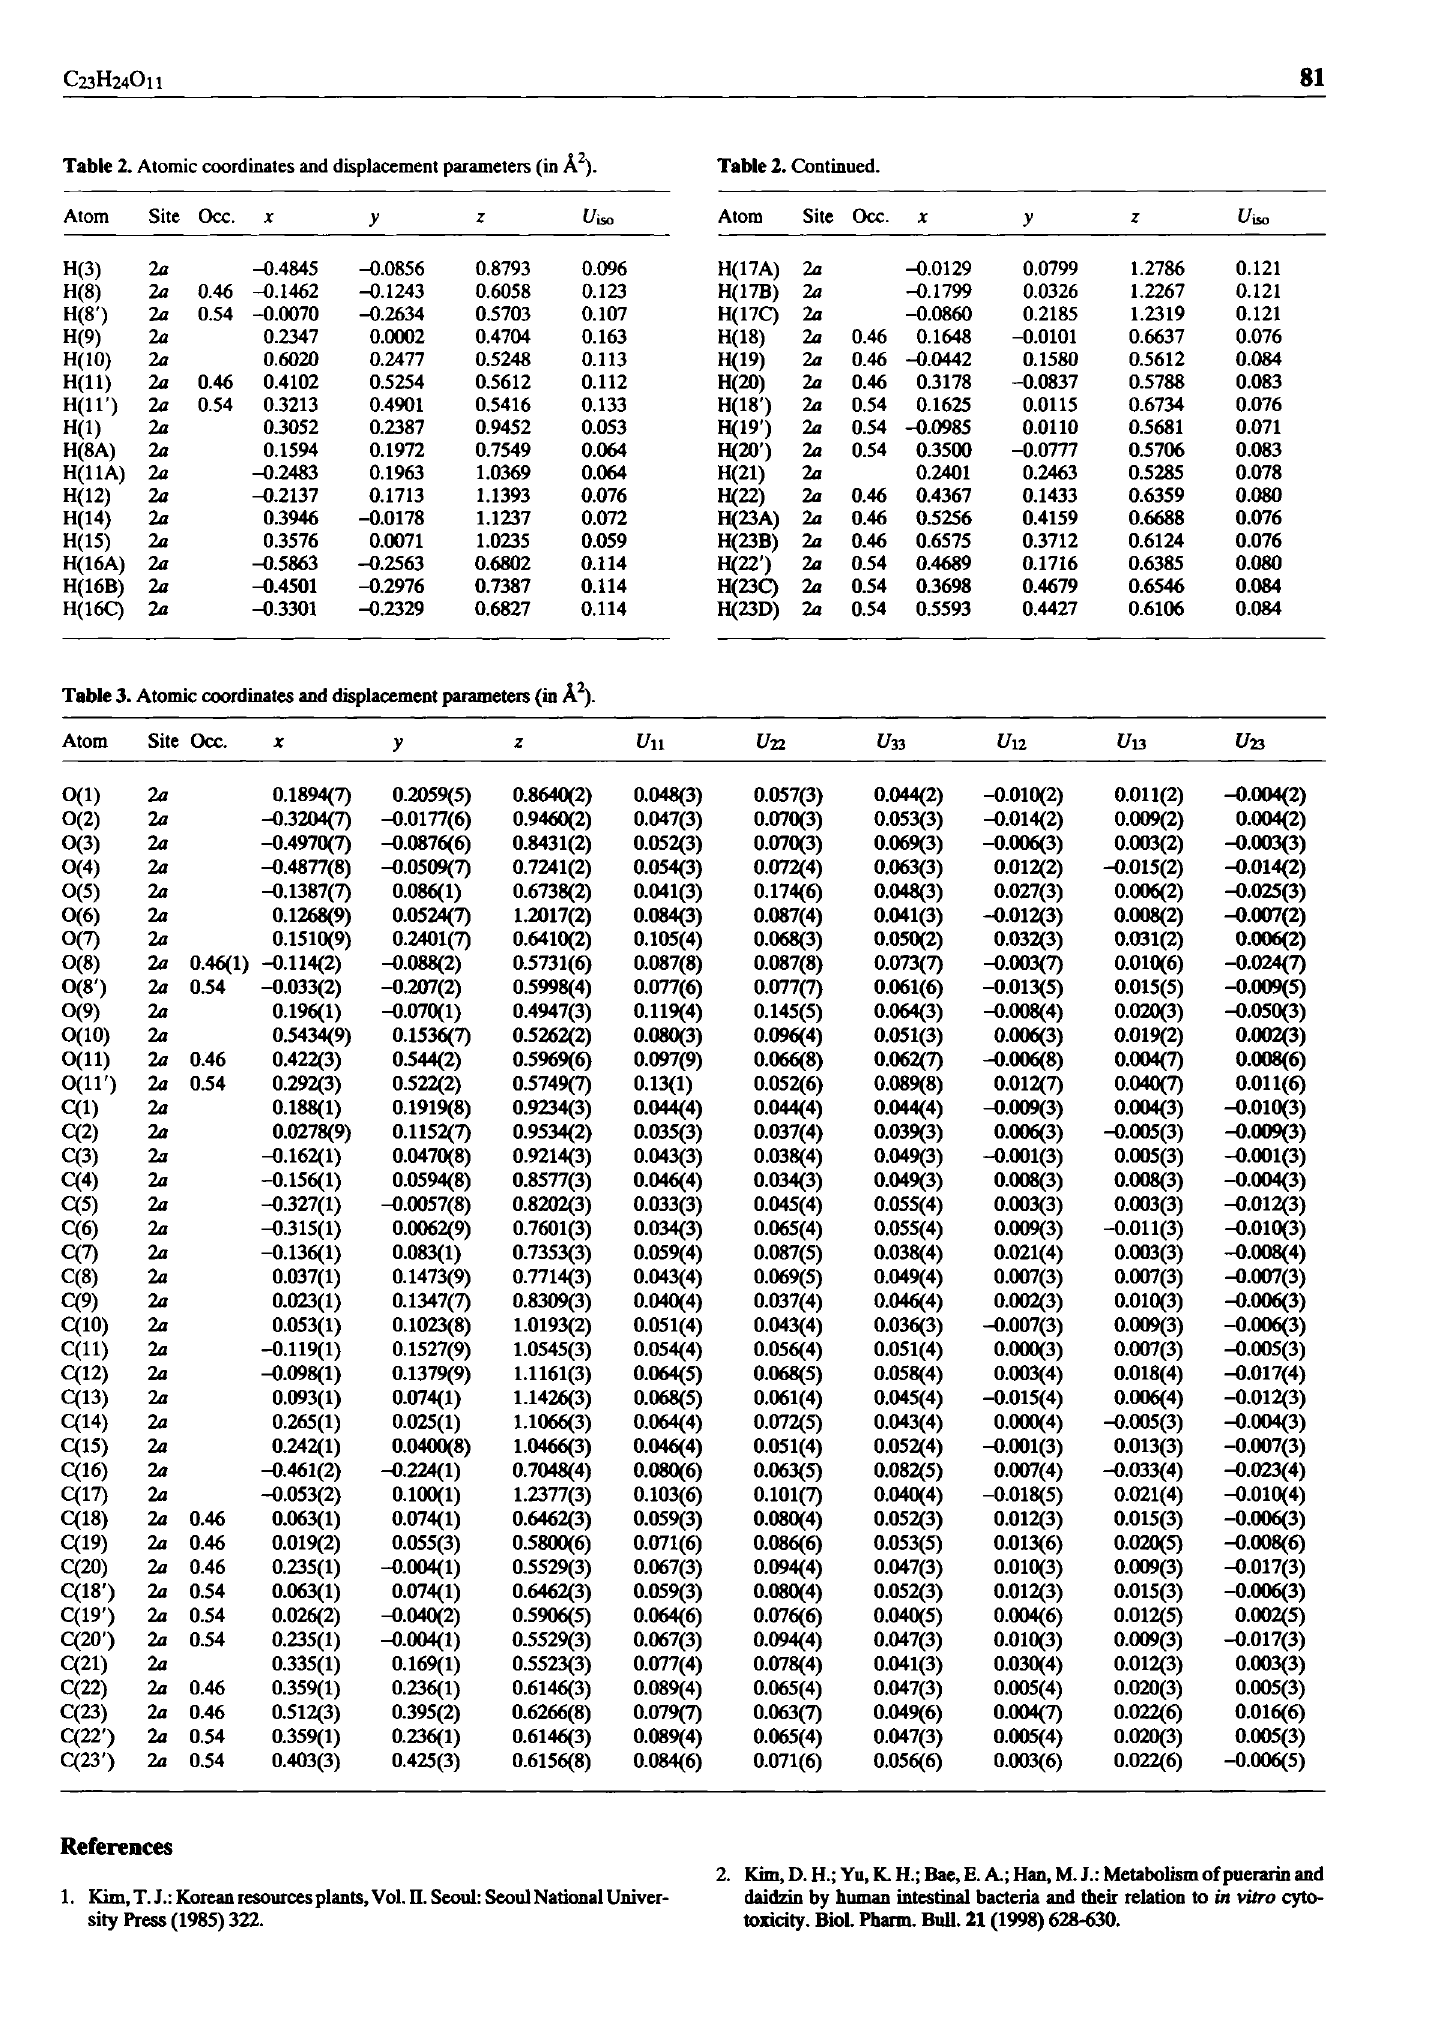
Table 2. Atomic coordinates and displacement parameters (in Ä 2 ).